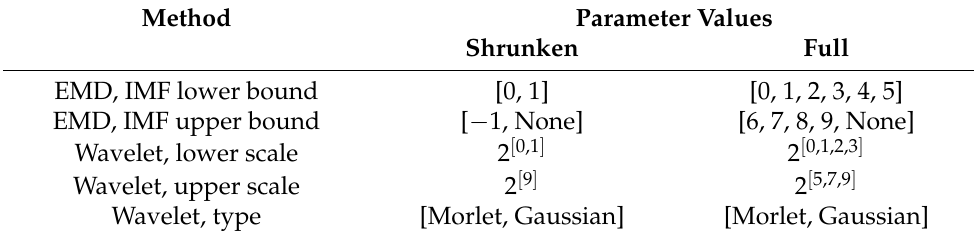
Table 2. The table provides details of the signal processing hyperparameter optimisation for EMD and wavelet methods. The parameters in the square brackets correspond to the sets of values used in the search space. The − 1 value corresponds to the second largest available value and None indicates an absence of the bound. The ’shrunken’ space is used for the 250 k data points configuration and ’full’ for the 5 k